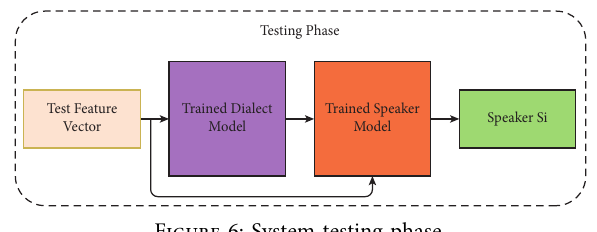
Figure 6: System testing